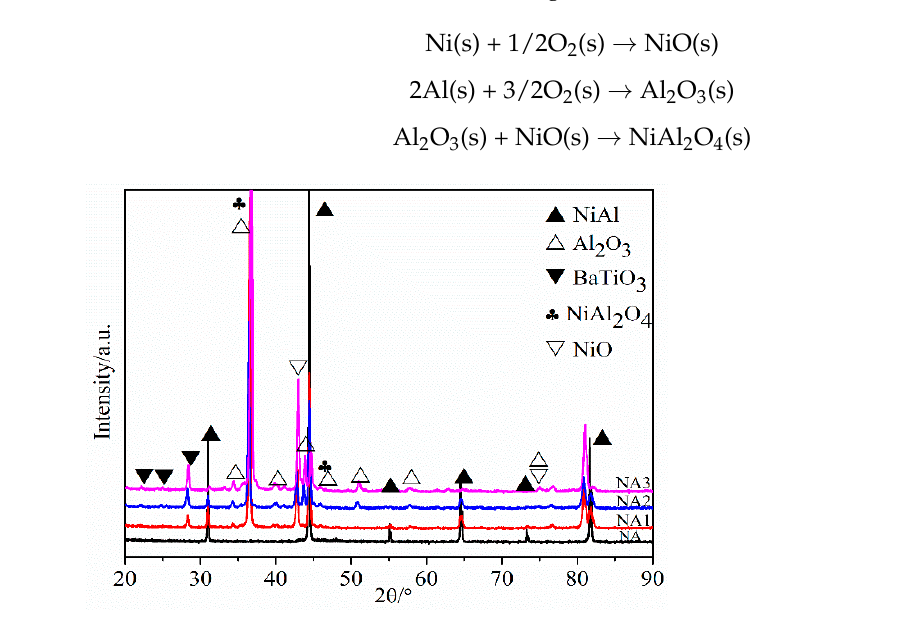
Figure 5. XRD patterns of the composites after oxidation.